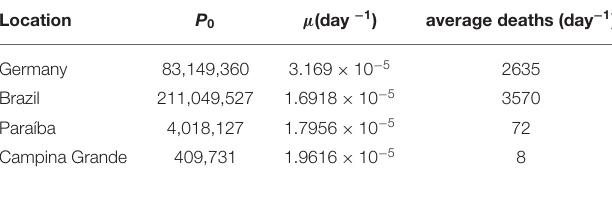
TABLE 3 | Pre-pandemic populations and average daily deaths.